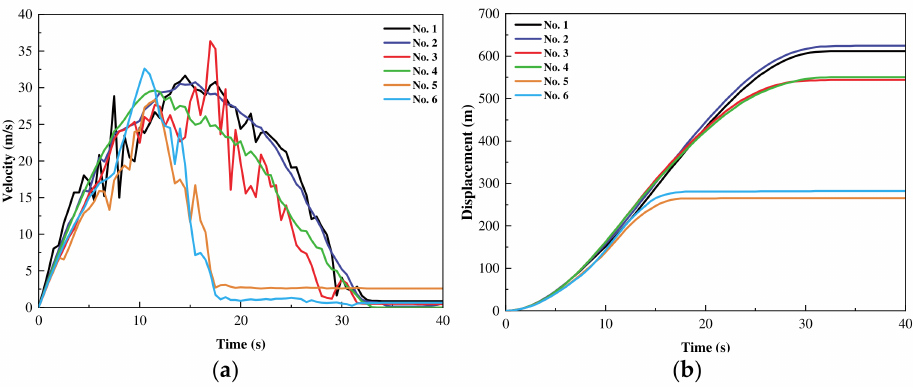
Figure 12. Changes in ( a ) velocity and ( b ) displacement of the accumulation layer at different monitoring points.